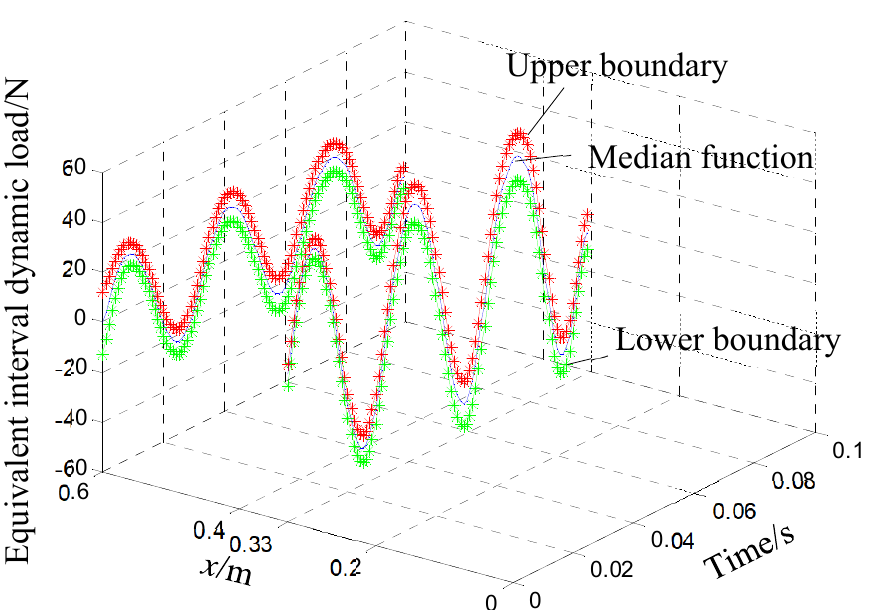
Figure 12. Interval process models of the identified random dynamic loads. According to Equation (5), the self-correlation coefficient functions of the loads are calculated by using the smoothed radius functions. Generally, when the self-correlation coefficient function of the excitation load is only related to the time intervals, the one with the response of a linear time-invariant structure is also a function of the time interval, in theory. Considering that there is a certain error in the identified load covariance matrix, the covariance of the same time interval in the matrix is not exactly the same. In this paper, all of the correlation coefficient values with the same time interval are averaged by performing Equation (41), and the approximation of the equivalent load self-correlation coefficient functions are obtained, which are shown in Figure 13 by the red and blue dotted lines. In this example, because the spatial dimension and the time dimension of the distributed random dynamic load are assumed to be independent of each other, the self-correlation coefficient functions of the two random concentrated dynamic loads that are identified equivalently should be consistent with the one of the original distributed load. By comparing the self- correlation coefficient function (blue solid line) of the original load time history with the ones of the identified equivalent loads, it is found that the three curves are quite similar. In order to verify the effectiveness of the identified correlation coefficient functions, a new load covariance matrix is calculated according to Equation (6) on the basis of the correlation functions in Figure 13 and the radius functions in Figure 11, and the covariance matrix of the same two measuring points is calculated through the forward model of Equation (36a), as is shown in Figure 14. By comparing Figure 14 with Figure 9, it is found that they are quite consistent. The overall relative error between them is only 8.34%, which shows the effectiveness of the identification